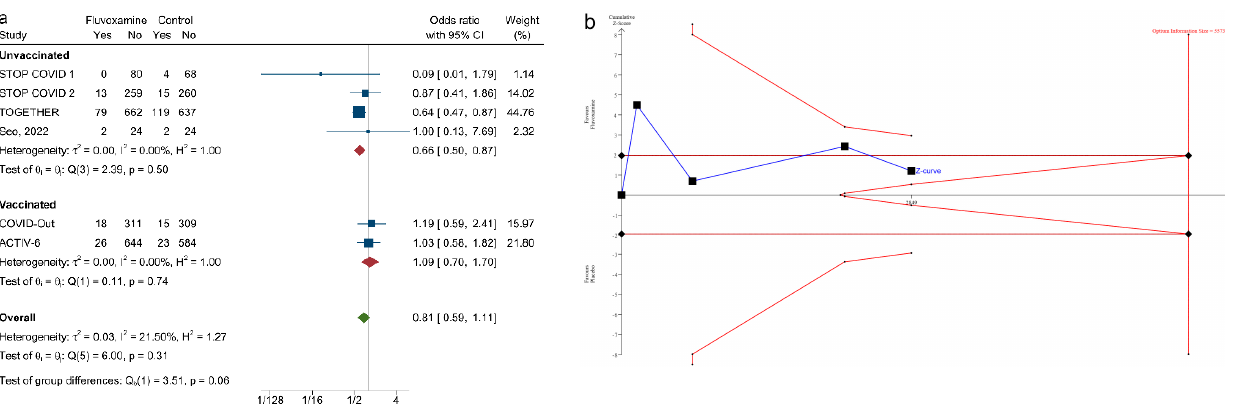
Figure 7. ( a ). Subgroup analysis of the unvaccinated group vs. the vaccinated group. ([6–8,16–18]) ( b ). Trial sequential analysis of the subgroup of the unvaccinated group on the primary outcome using a 30% relative risk reduction threshold.